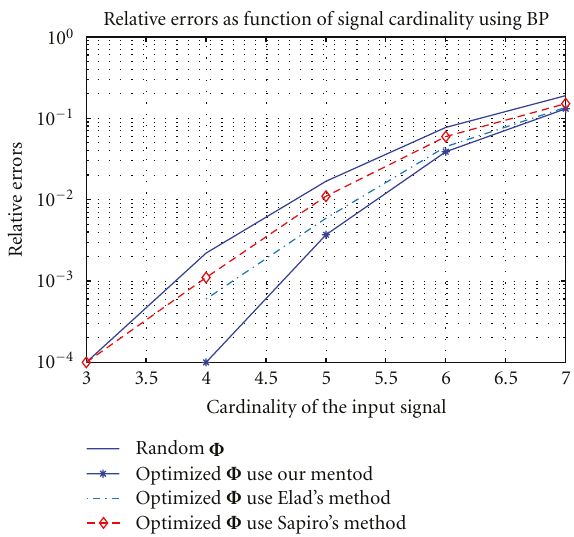
Figure 5: CS relative errors as function of signal cardinality using BP.